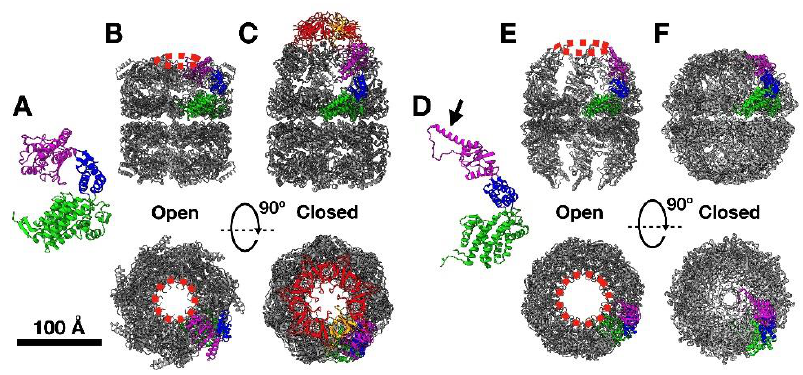
Figure 1. Structure of the chaperonins. ( A ) The atomic structure of a GroEL monomer (pdb 1KP8), with the equatorial domain (green), apical domain (purple), and intermediate domain (blue). ( B , C ) Two orthogonal views of the atomic structure of a Type I chaperonin oligomer in its open ( B ) and closed ( C ) conformations, in the latter case induced by the presence of the small oligomer GroES (red and one of the monomers in orange). The atomic structures correspond to GroEL (pdb 1KP8) and the GroEL/GroES complex (pdb 1AON), respectively. The dashed lines (red) mark the surface formed by the apical domains that is responsible for interaction with misfolded proteins. ( D ) The atomic structure of a Type II monomer, the thermosome from Methanococcus maripaludis (pdb 3IZH). The three domains are coloured as in ( A ). The black arrow indicates the helical extension responsible for closure of the cavity see ( F ). ( E , F ) Two orthogonal views of the atomic structure of a Type II chaperonin oligomer ( E ) in its open conformation (thermosome from Methanococcus maripaludis ; pdb 3IZH) and ( F ) in its closed conformation (thermosome from Thermococcus strain KS1; pdb 1Q3R). The dashed circles (red) mark the surface formed by the apical domains that is responsible for part of the interactions with misfolded proteins. Bar = 100 Å for B, C, E and F.